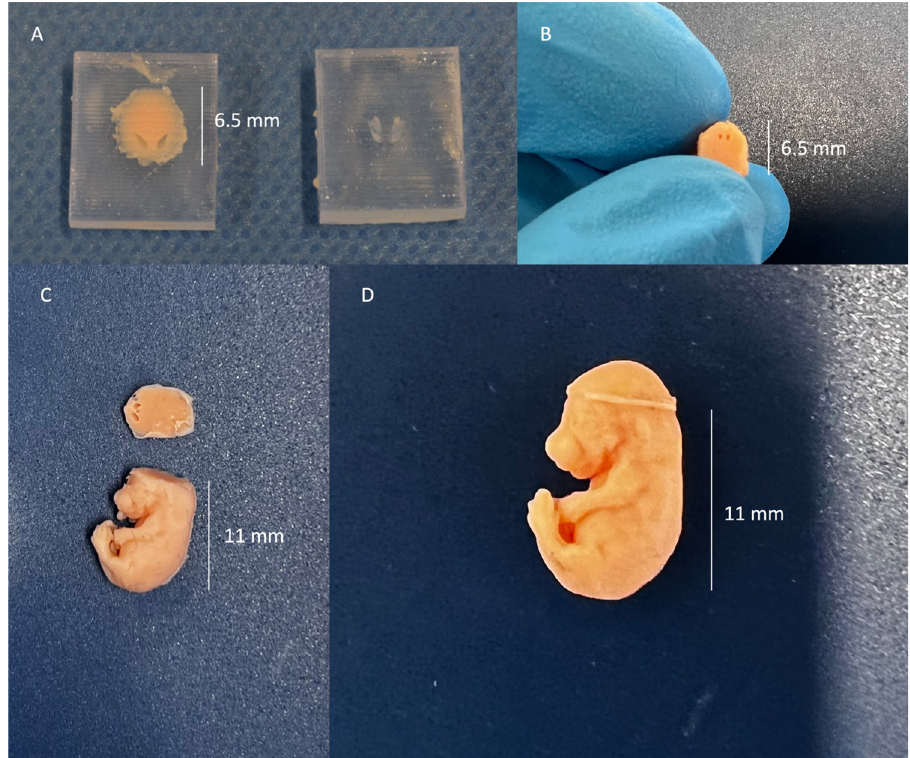
Fig 3. Assembly of the silicone embryo model. (A) The upper part of the head of the embryo model. The silicone was poured into the mold and hardened overnight. Due to the partial shape of the lateral ventricle on the mold cover on the right, the silicone contains two cavities representing the respective part of the lateral ventricle. (B) The model of the embryo body as seen above. Using a cover, the remaining shape of the lateral ventricle is represented as two cavities in the embryo model. (C) The upper and lower parts of the embryo model are assembled so that the two parts of the lateral ventricle meet each other. (D) The silicone embryo model was assembled with the upper and lower parts glued. The two parts of the lateral ventricle meet each other due to automatic registration in the design process, forming the complete shape of the lateral ventricle.